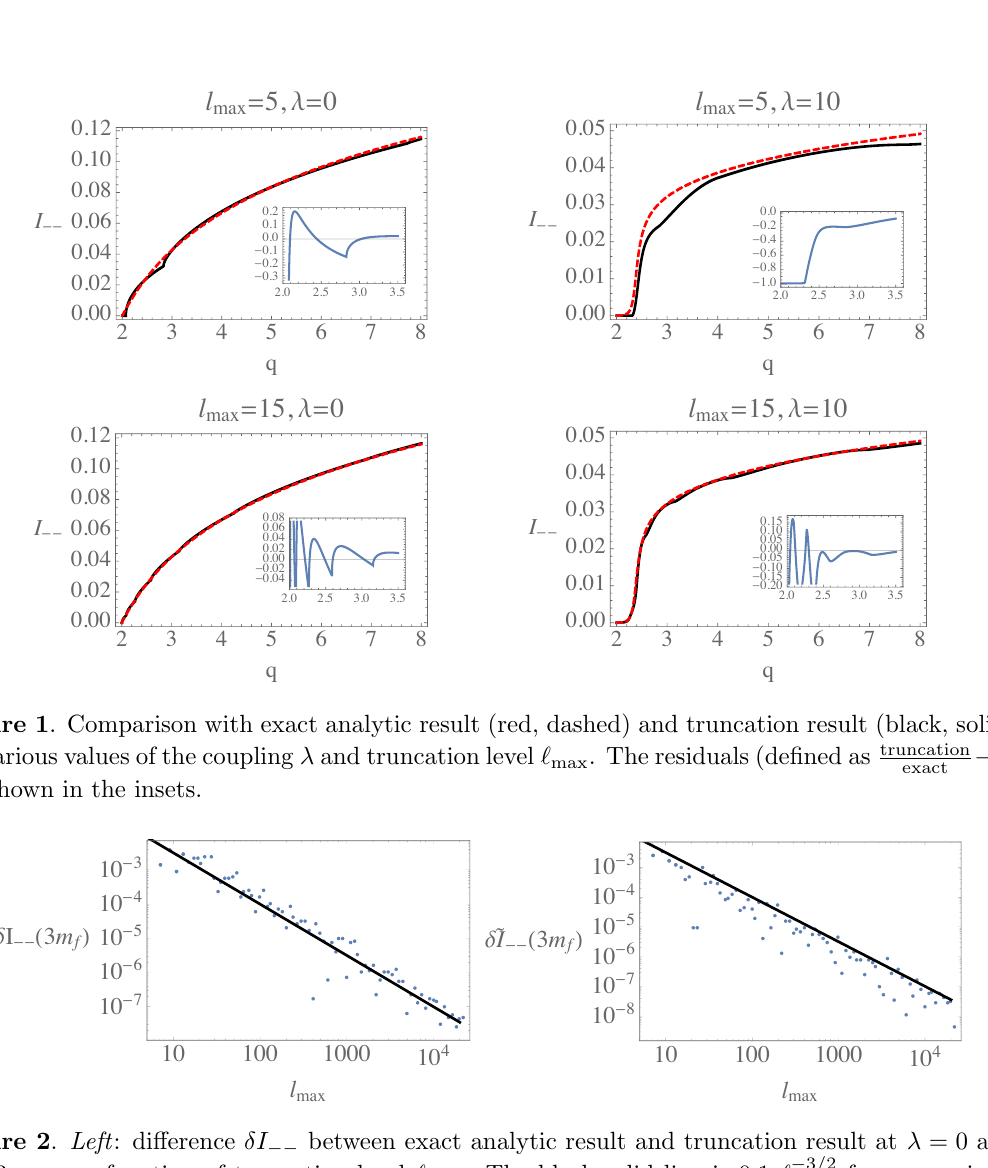
Figure 2 . Left : di(cid:11)erence (cid:14)I (cid:0)(cid:0) between exact analytic result and truncation result at (cid:21) = 0 and q = 3 m f as a function of truncation level ‘ max . The black solid line is 0.1 ‘ (cid:0) 3 = 2 max for comparison. Right : analogous plot, but for the integrated value of h j (cid:0) j ~ D j j (cid:0) i